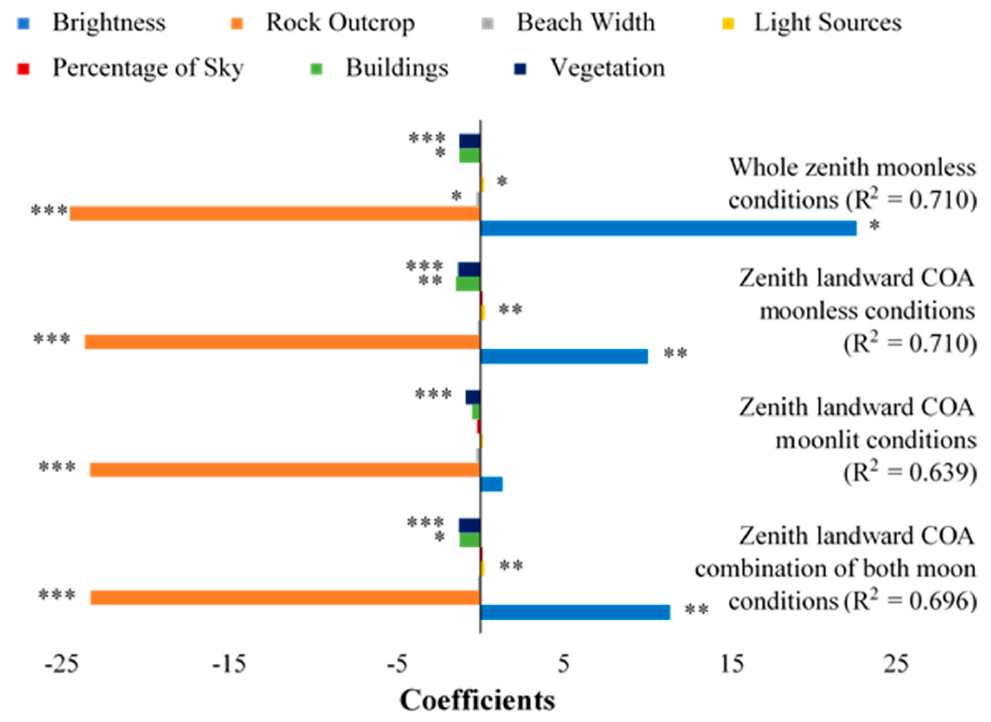
Figure 14. The coefficients for the variables determining sea turtle nesting density in the backward stepwise multiple linear regression models for zenith photographs’ whole image (top model) and zenith photographs’ landward cone of acceptance (COA) sectors (bottom three models). Significant variables are denoted with an asterisk (* = p < 0.05, ** = p < 0.01, *** = p < 0.001) and the adjusted R 2 for each model shown.